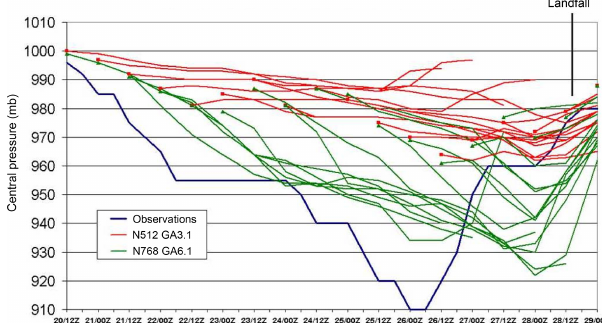
Figure 12. Central pressure evolution from successive forecasts for Typhoon Bolaven from data assimilation trials. The red lines are GA3.1 at N512 and green are GA6 at